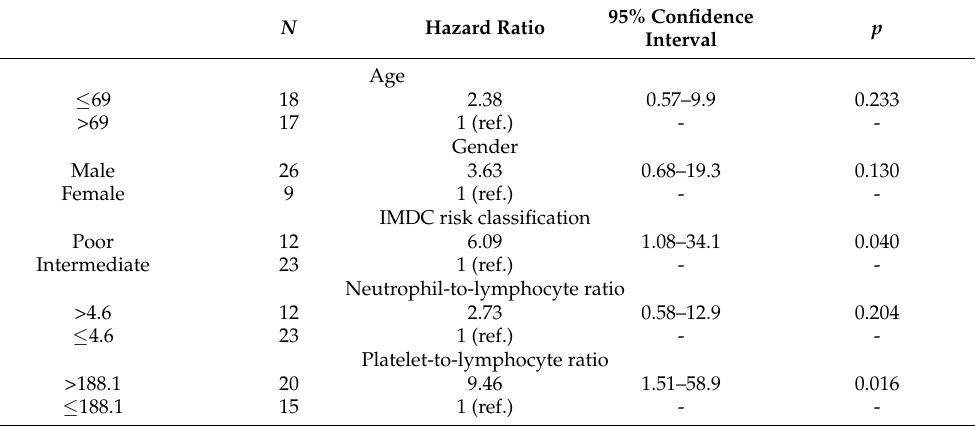
Table 2. The treatment effect in patients who received NIVO+IPI and nivolumab. Number 35 Objective response rate (CR + PR, number, %) 12 (34.3) Disease control rate (CR + PR + SD, number, %) 28 (80.0) Best overall response (number, %, 95% CI) CR 3 (8.6) PR 9 (25.7) SD 16 (45.7) PD 7 (23.5) NIVO+IPI: Combination nivolumab plus ipilimumab; CR: Complete response; PR: Partial response; SD: Stable disease; PD: Progression disease.